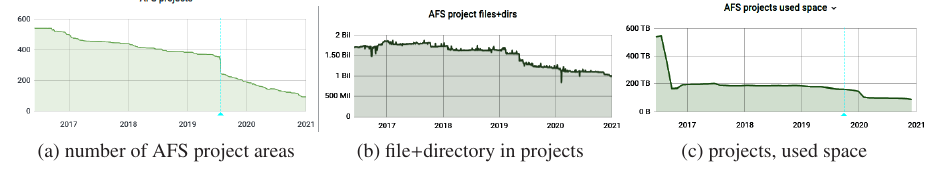
Figure 2: AFS project area phaseout over